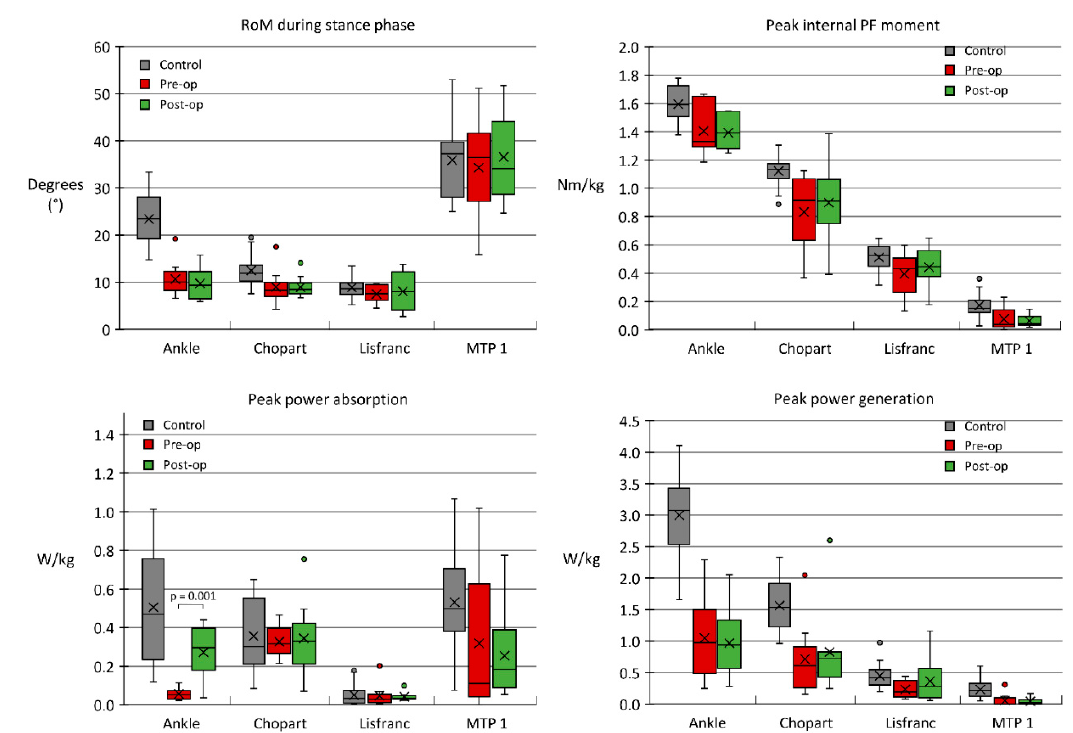
Figure 3. Distribution, mean (X) and median (horizontal line in box) of peak kinematic and kinetic variables during the stance phase of barefoot walking in control subjects (white), pre ‐ operative (dark grey) subjects, and post ‐ operative subjects (light grey). A paired t ‐ test ( α = 0.05) was performed to calculate differences between pre ‐ and post ‐ operative data. PF: plantar flexion.